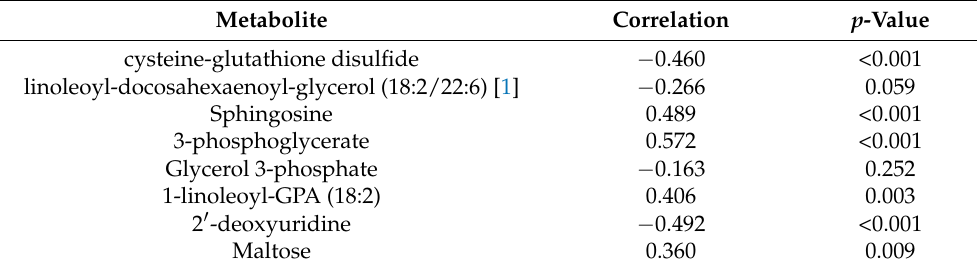
Table 8. Partial spearman correlation between SF-MPQ sensory score and top metabolites contributing to group separation per RF, adjusted for ID.